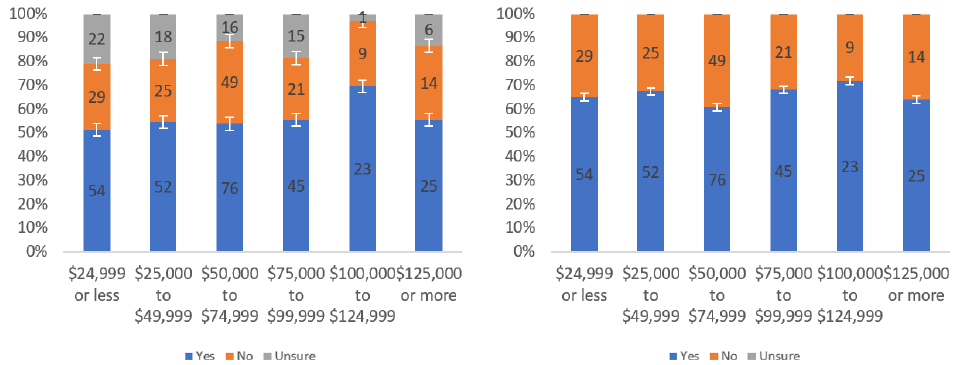
Figure A37. Responses regarding respondents’ willingness to review by income level including ( left ) and excluding ( right ) unsure responses.